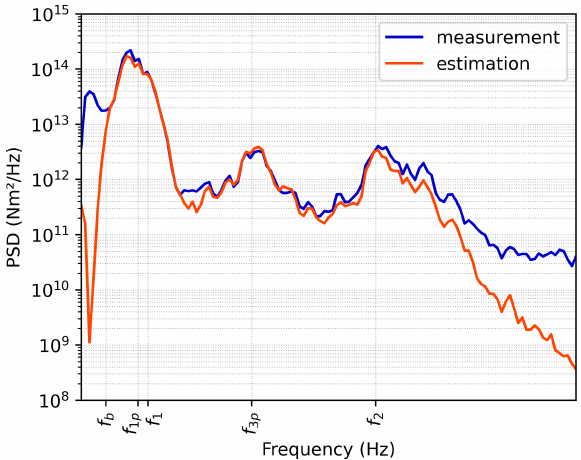
Figure 4. PSD of dynamic bending moment and corresponding estimation in FA direction at height = − 31 m LAT and wind speed = 15.8 ms − 1